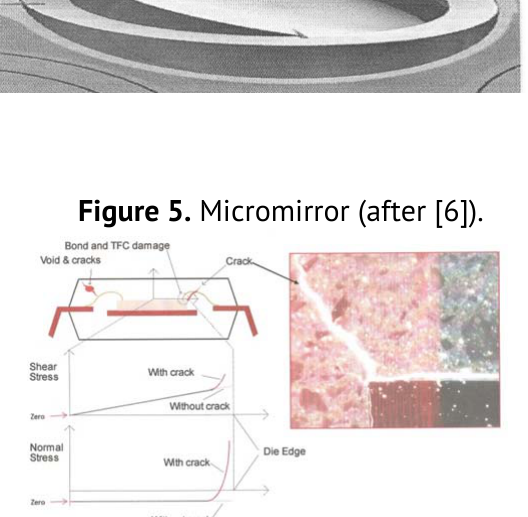
Figure 7. Cracking due to temperature cycle.